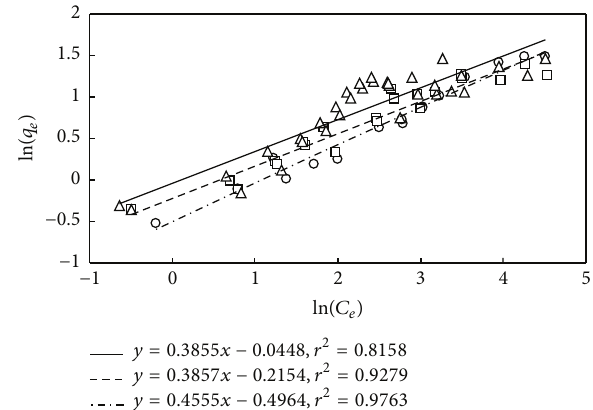
Figure 9: Adsorption of DMP on M-PVAL employing Freundlich isotherm. Cases with pH 0 = 5, 6.04–6.64, and 7 are expressed as ◻ (--): 𝑦 = 0.3857𝑥 − 0.2145 , I (- ⋅ -): 𝑦 = 0.4555𝑥 − 0.4964 , and △ (—): 𝑦 = 0.3855𝑥 − 0.0448